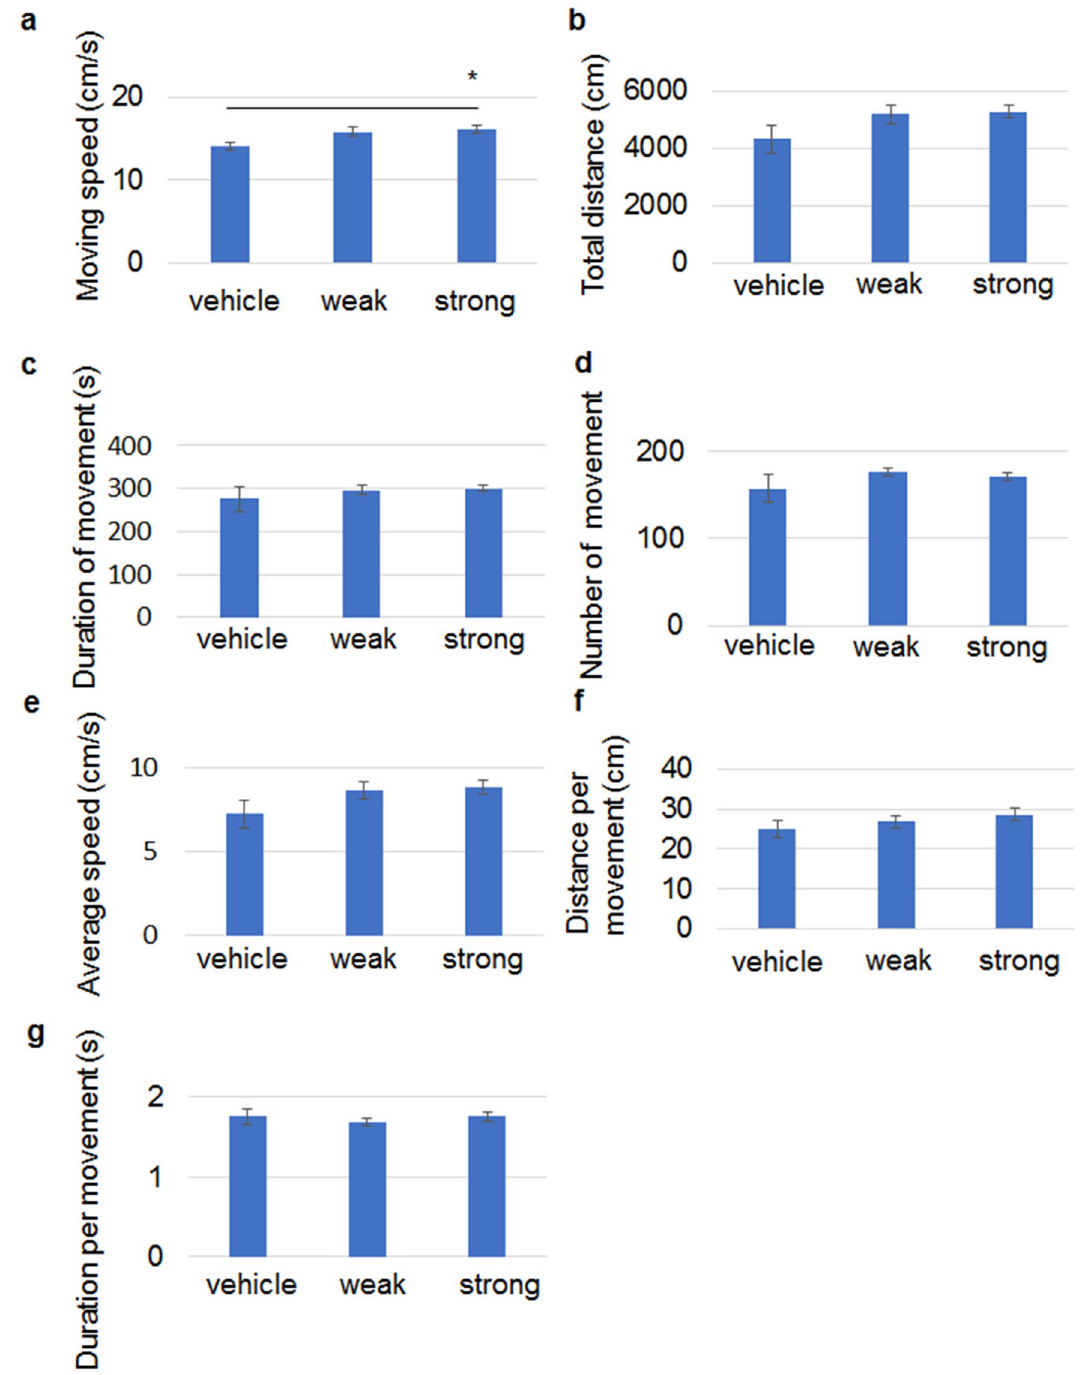
Figure 7. Strong aggregates of 13A increases moving speed in open field at 1 months of age. Open field test of 1-month-old mice that received an injection of vehicle (n = 11), 13A with weak aggregation (n = 17) or 13A with strong aggregation (n = 13) at P2. The indices used were moving speed ( a ), total walking distance ( b ), duration of movement ( c ), number of movement episode ( d ), average speed of locomotion over 10 min ( e ), distance per movement ( f ) and duration per movement ( g ). Each error bar represents SE. ANOVA followed by post hoc test, *p <